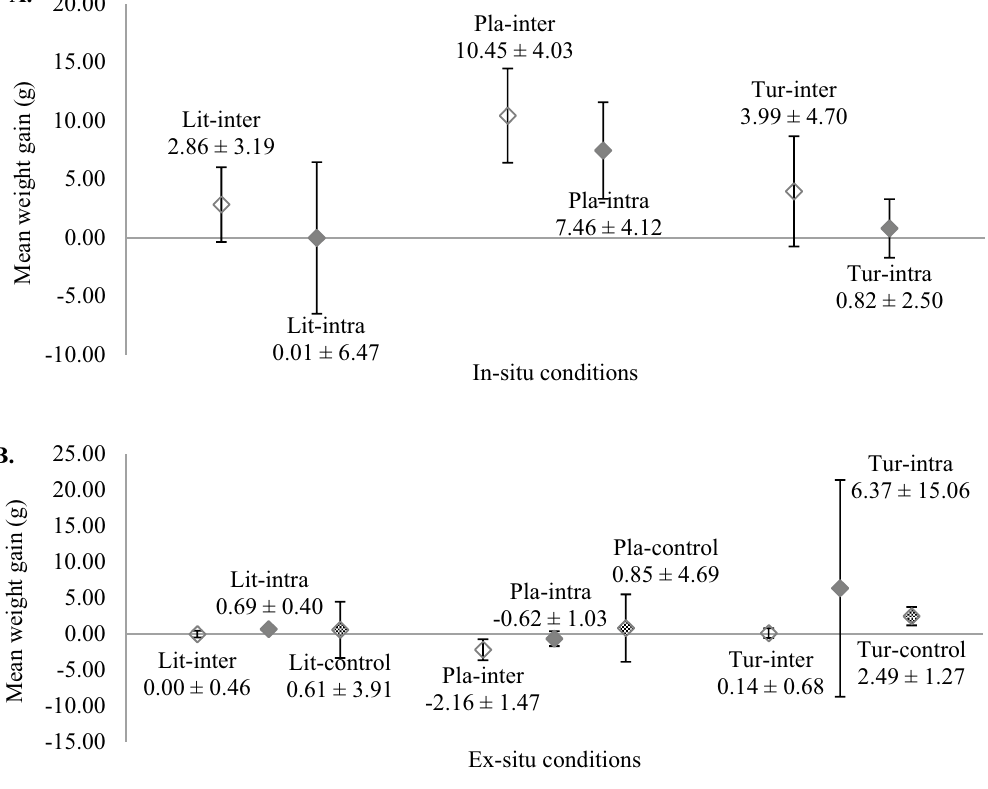
Figure 2. ( A ) Weight gain (mean ± S.D.; n = 8) of micro-colonies of three coral species after 3 months during which they were either subjected to intra- and inter-specific interactions under in-situ conditions. ( B ) Weight gain (mean ± S.D.; all treatments: n = 8 except control treatment: n = 16) of micro-colonies of three coral species after 3 months during which they were either subjected to intra- and inter-specific interactions or no interaction (control) under ex-situ conditions. Lit-inter = Lithophyllon undulatum in interspecific interaction; Lit-intra = Lithophyllon undulatum in intraspecific interaction; Lit-control = Lithophyllon undulatum without interaction; Pla-inter = Platygyra sinensis in interspecific interaction; Pla-intra = Platygyra sinensis in intraspecific interaction; Pla-control = Platygyra sinensis without interaction; Tur-inter = Turbinaria mesenterina in interspecific interaction; Tur-intra = Turbinaria mesenterina in intraspecific interaction; Tur-control = Turbinaria mesenterina without